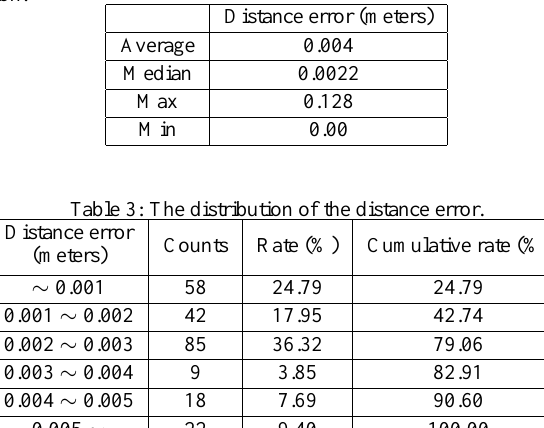
Figure 17: A part where the distance error is large. Table 2: The statistical evaluation of the boundary points extrac- tion.